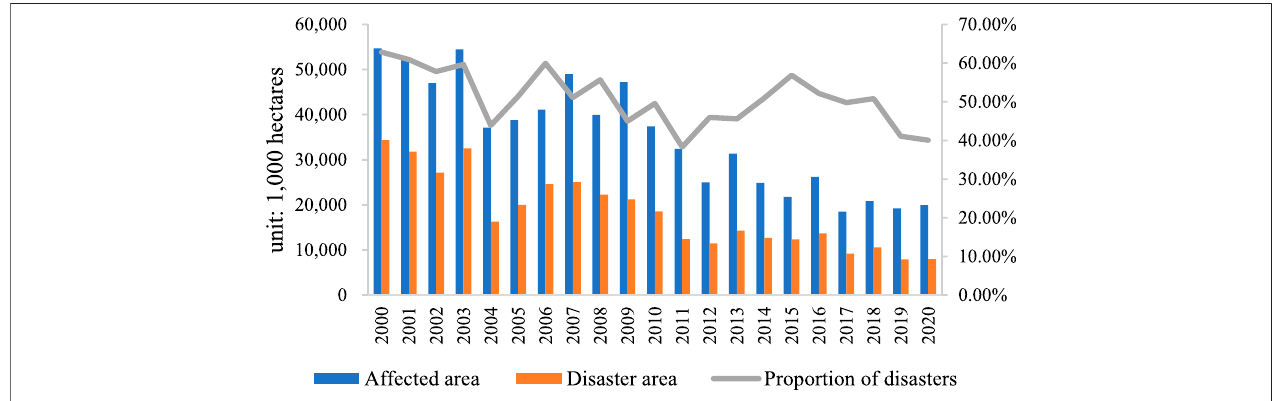
FIGURE 1 | The affected area, disaster area, and the proportion of disasters in China from 2000 to 2020 (Data source: National Bureau of Statistics of China).